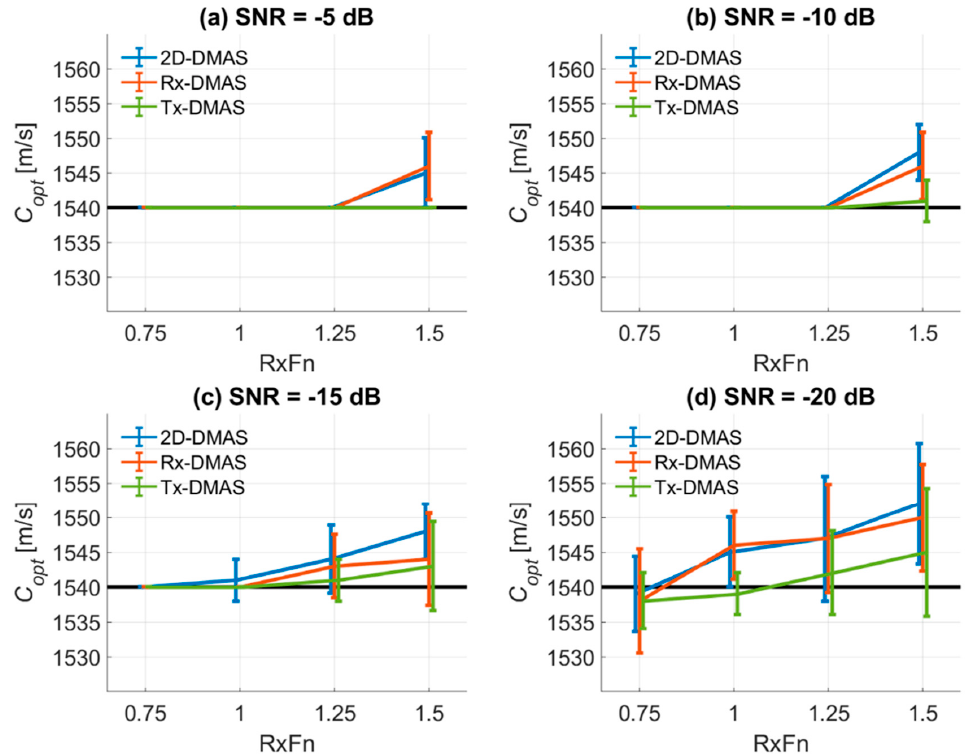
ff erent DMAS methods as a function of RxFn and channel Figure 4. Plot of C opt in different DMAS methods as a function of RxFn and channel SNR. Figure 4. Plot of C opt in di